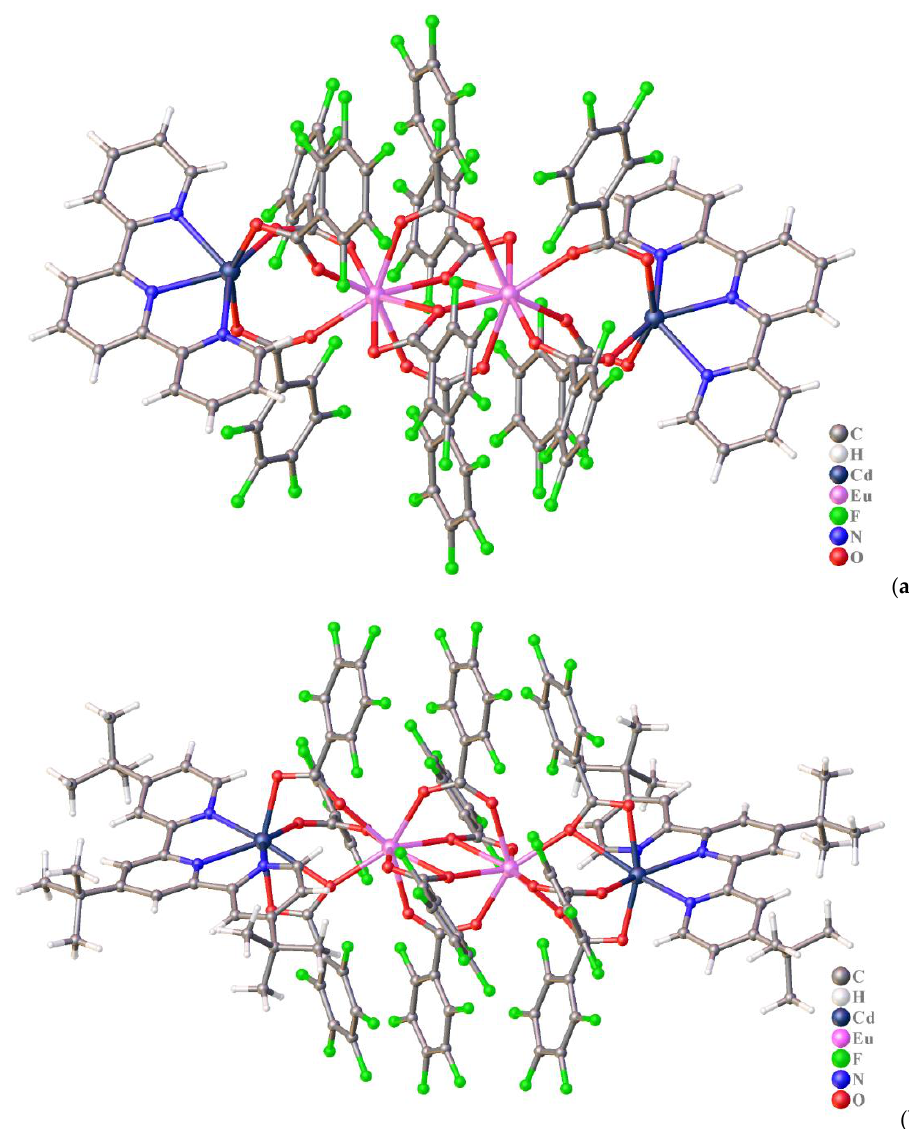
Figure 2. The molecular structure of 2 Eu ( a ) and 3 Eu ( b ). In 2 Eu and 3 Eu the polyhedra of neighboring Eu ions have a common edge, (Figure 3). There are no common elements between the cadmium and europium polyhedra in 2 Eu , while in 3 Eu there is a common vertex represented by the oxygen atom of the chelate-